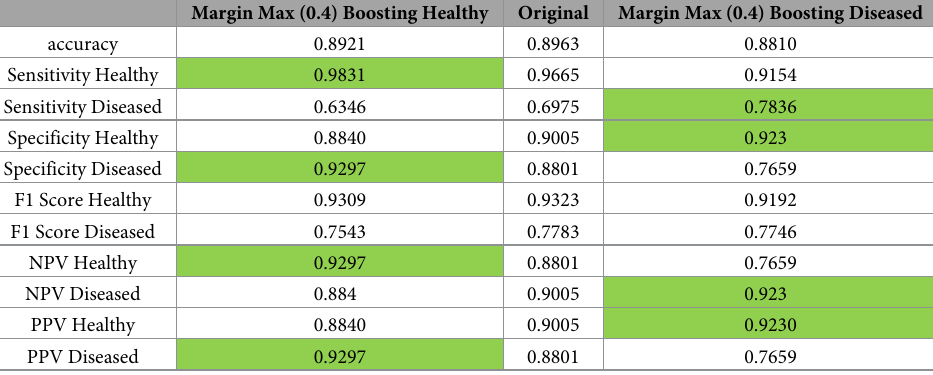
Table 8. Sensitivity boost of the ‘un-curated’ dataset with two labels, for healthy and diseased